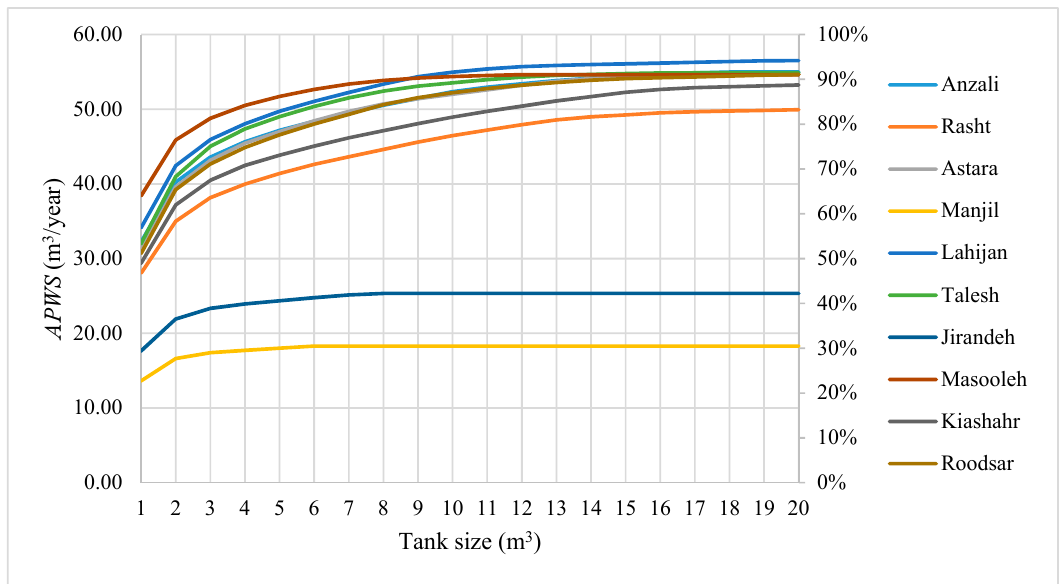
Figure 4. The relation between tank size and APWS for all stations (Scenario A).